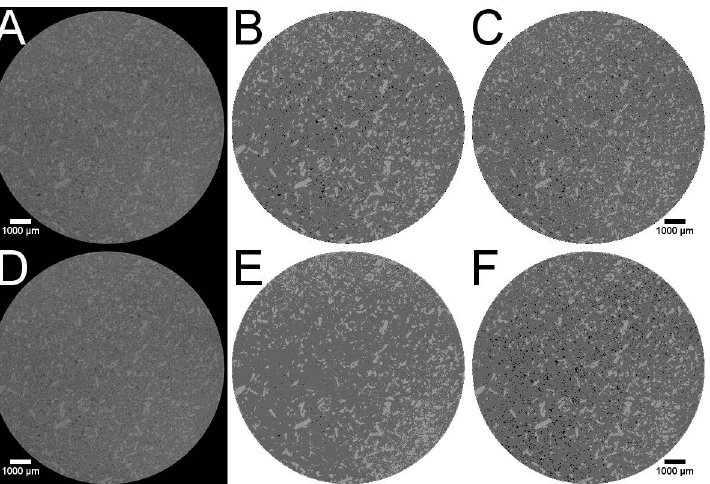
Figure 2. Cross-section 84 of different virtual tablets based on the X µ CT image of tablet 3 of batch T25E75. Theophylline is always displayed as light grey, ethyl cellulose as dark grey, and air as black. The scale of all images is equal. ( A , D ) Binned X µ CT image. ( B ) Virtual tablet T1. ( C ) Virtual tablet T2. ( E ) Virtual tablet T4. ( F ) Virtual tablet